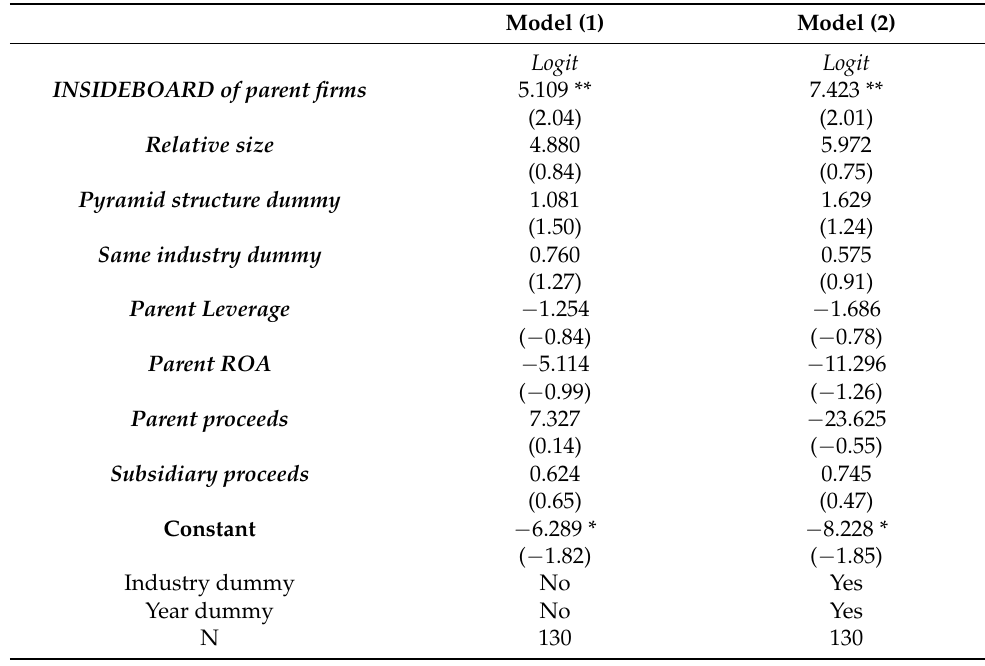
Table 7. Determinants of young dual directors holding the CEO position. This table presents the results of logit regressions of young dual directors holding the CEO position. The dependent variable is Young dual director holding CEO position , which takes a value of 1 for firms with at least 1 young dual director holding the CEO position in the subsidiary firm and 0 otherwise. INSIDEBOARD is the proportion of inside boards of parent firms. Relative size is the subsidiary’s total assets divided by the parent’s total assets before carve-outs. See Appendix A Table A1 for variable definition. z-statistics computed using heteroskedasticity-consistent standard errors (clustered by industry) are in parentheses. *, ** indicate significance at the 10%, 5% levels,